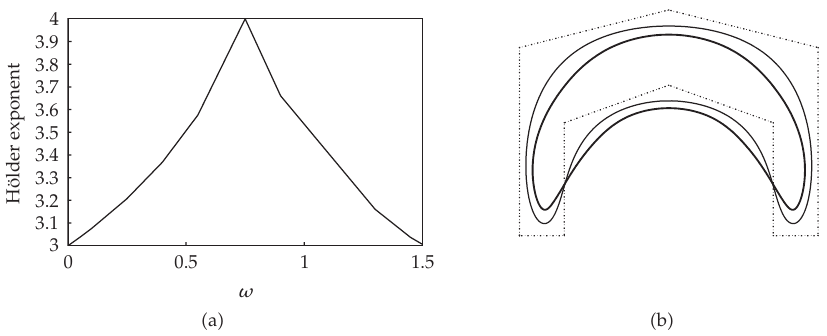
Figure 1: (cid:2) a (cid:3) Graph against H¨oder exponent and parameter 0 < ω < 1 . 5 for a 4-point quaternary scheme. (cid:2) b (cid:3) The dotted lines are control polygon; whereas the bold and thin solid lines are produced by setting ω (cid:8) 0 . 02 , 0 . 75 ,